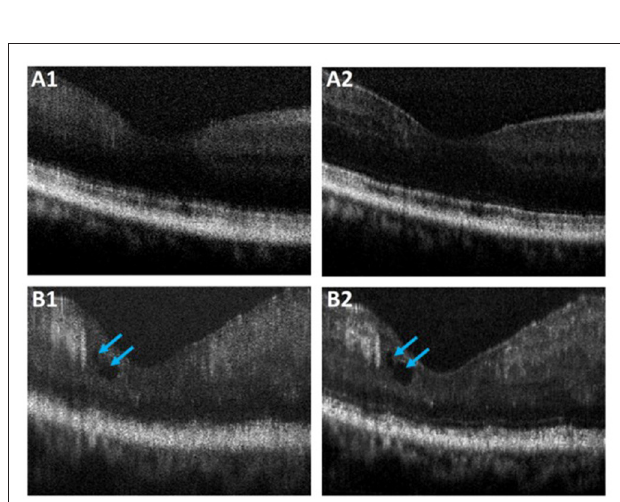
FIGURE 7 | Representative OCT B-scans of proliferative diabetic retinopathy (DR) patients without (A) and with (B) macular edema (blue arrowheads). The compensated B-scans (A2,B2) obtained from the proposed ADC-Net illustrate higher contrast and sharpness compared to the raw uncompensated B-scans (A1,B1)